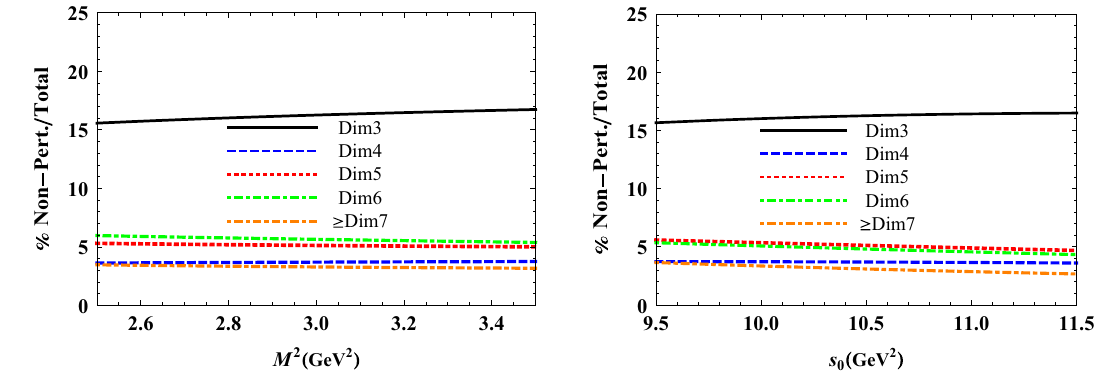
Fig. 7 Nonperturbative contributions to (cid:6) QCD ( M 2 , s 0 ) AV as functions of M 2 (left panel), and s 0 (right panel)